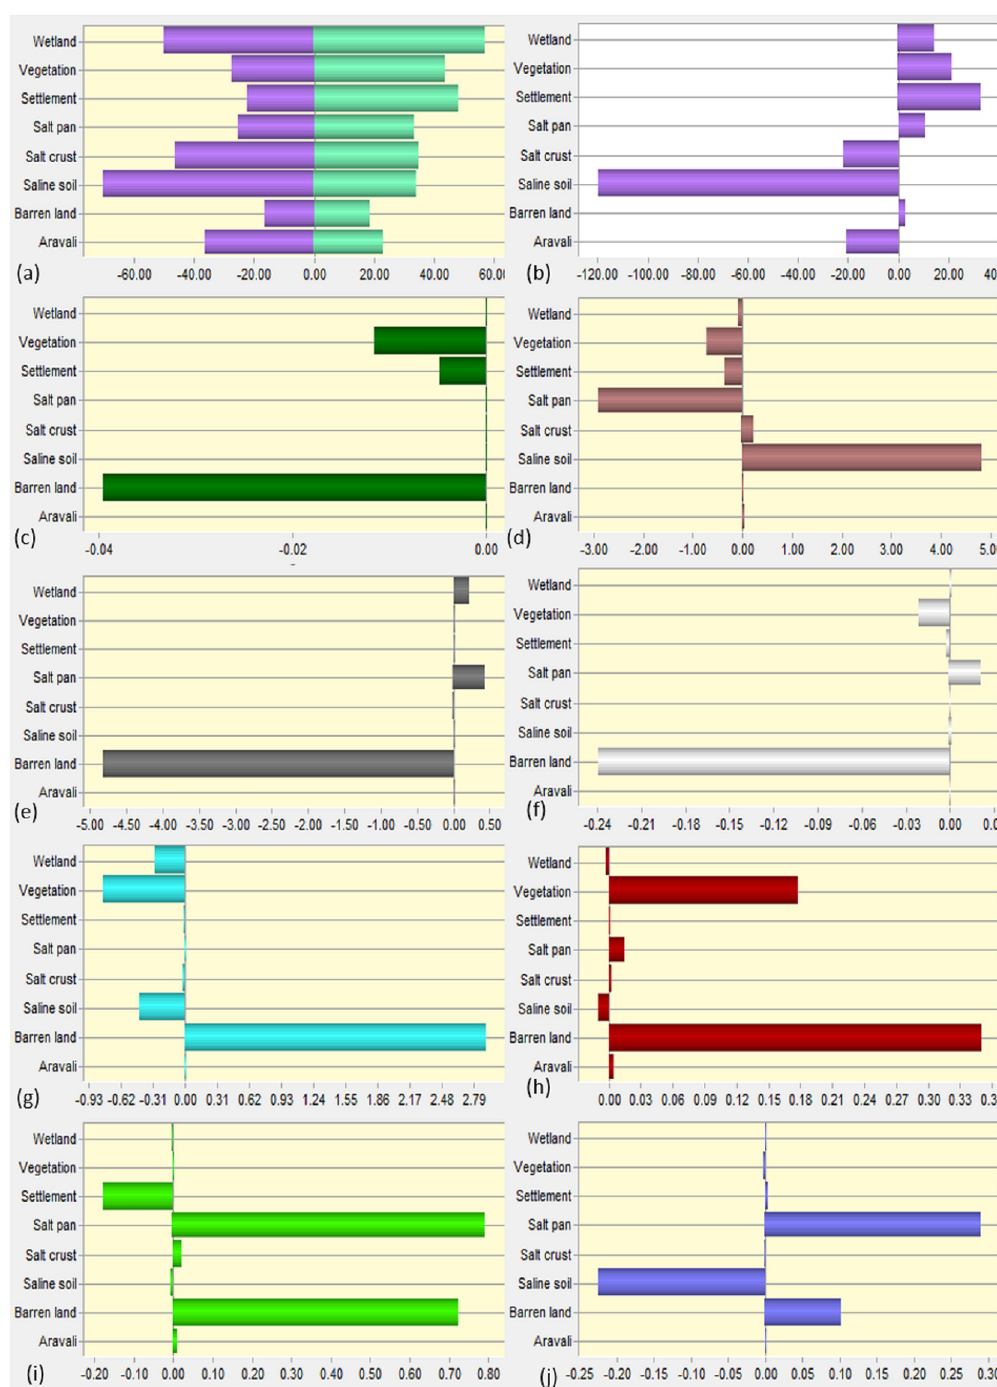
Fig 10. LULC change percentages. (a) gain and loss of LULC (b) net change between 2029 and 2059 and (c-j) contributions of each class to net changes.